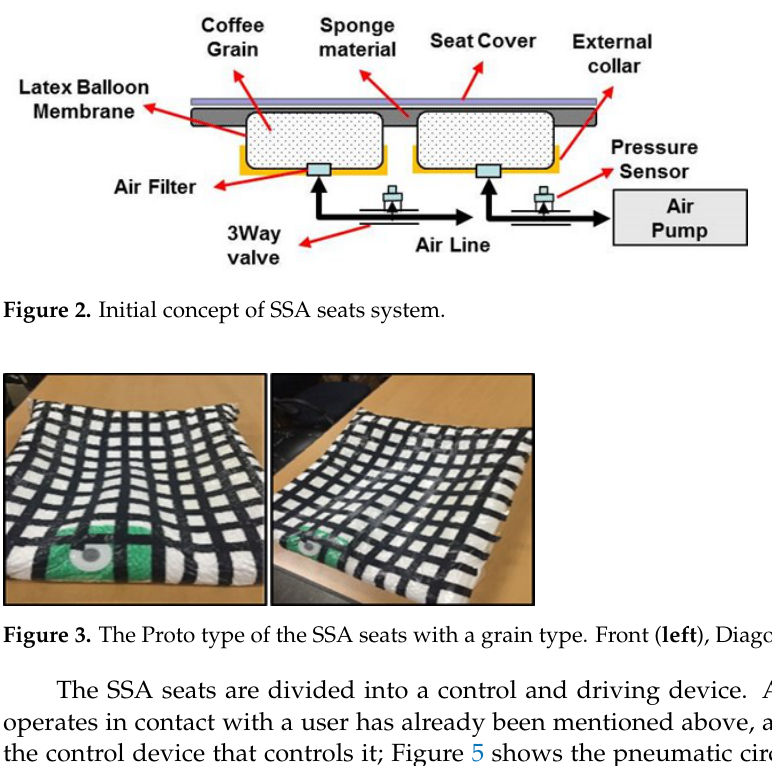
Figure 1. Material selection and unit configuration test.